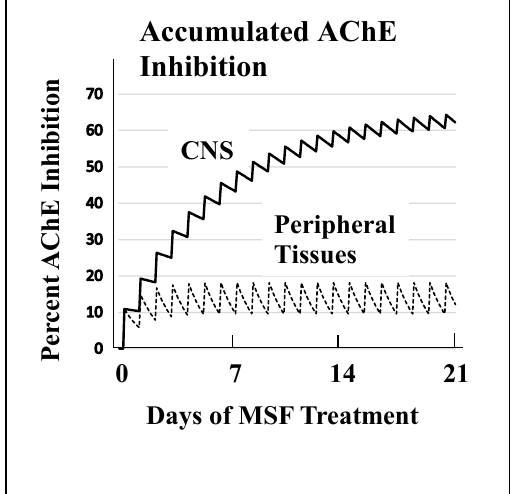
Figure 2. A computational model of the expected accumulated AChE inhibition in the CNS (upper solid line) versus peripheral tissues (lower dotted line) during three weeks of daily doses of an irreversible inhibitor (e.g., methanesulfonyl fluoride, MSF), computed as producing an equal 10% inhibition of currently active AChE in both CNS and peripheral tissues with each dose. The saw-tooth appearance of the lines shows the increment of inhibition (upward points) added with each dose. The downward slope between doses is the decrease in inhibition produced by new synthesis of the enzyme in the dose-to-dose interval. MSF disappears rapidly from blood, within a few hours, producing the pulsatile inhibition shown above. These pharmacological calculations (repeated dosing with recovery between doses) predict the accumulated effects occurring over 21 days [128]. The separation between the levels of CNS versus peripheral tissue accumulated AChE inhibition caused by differences in enzyme recovery rates, as shown above, does not occur with short-acting competitive or pseudo-irreversible inhibitors [69]. (Modified from Journal of Alzheimer’s Disease , 55,